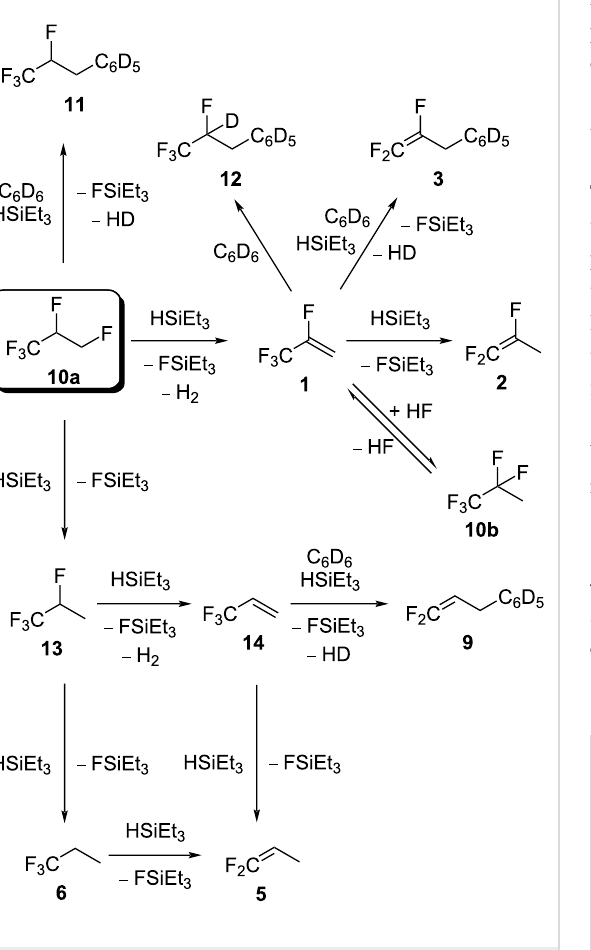
Scheme 8: Proposed reaction pathways starting from 10a in the pres- ence of ACF and